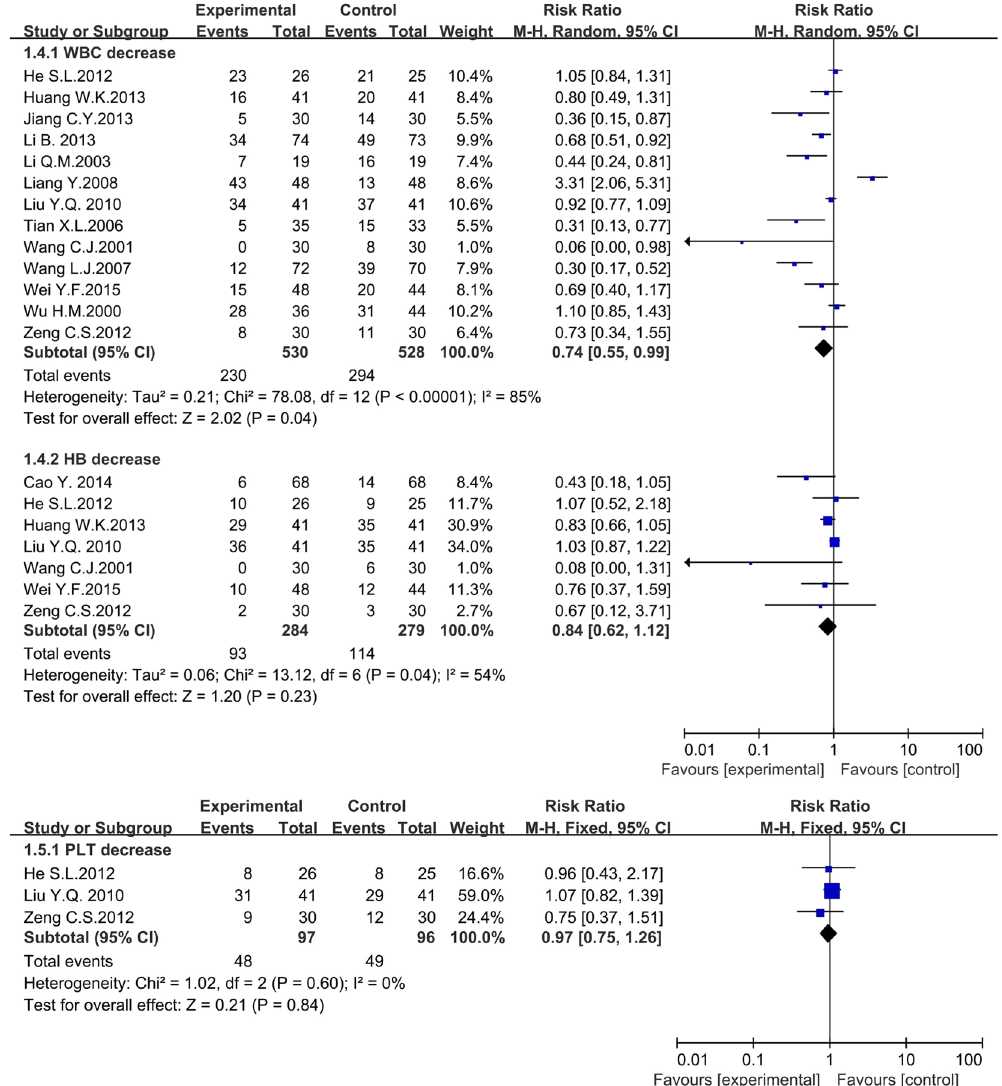
Figure 7. The forest plots of bone marrow depression (WBC decrease, HB decrease and PLT decrease) for traditional insect Chinese medicine and the related preparation combined chemotherapy versus chemotherapy alone (PLT: Platelets, WBC: White blood cell, HB: Hemoglobin, M-H : Mantel-Haenszel estimates; CI : Confidence